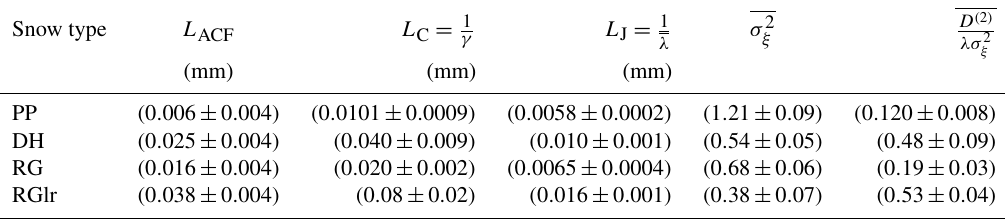
Table 2. Summary of the results for the correlation length scales L C = 1 for all snow types analyzed. The results were evaluated in the range of − 2 < R (cid:48) <